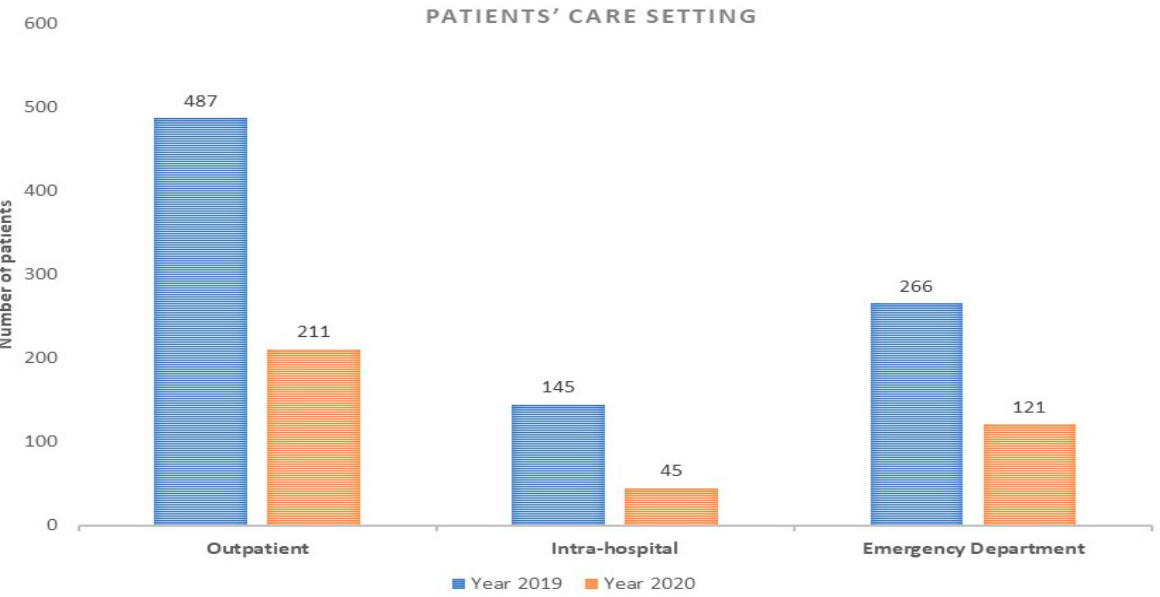
Figure 2. Patients’ care setting during 2019 and 2020 study periods.